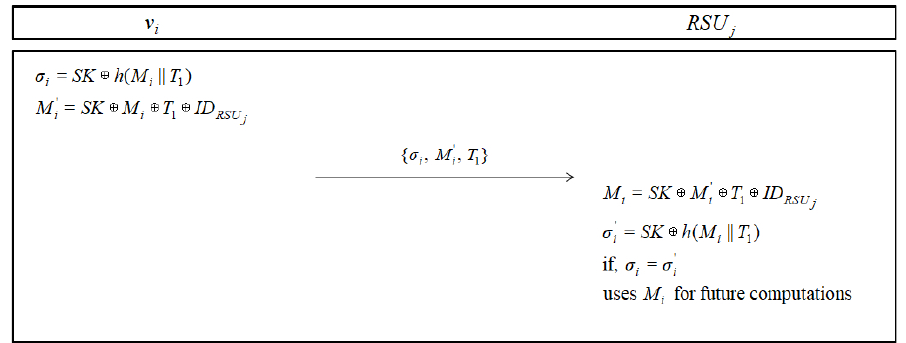
Figure 7. Message signature and confirmation phase of our proposed